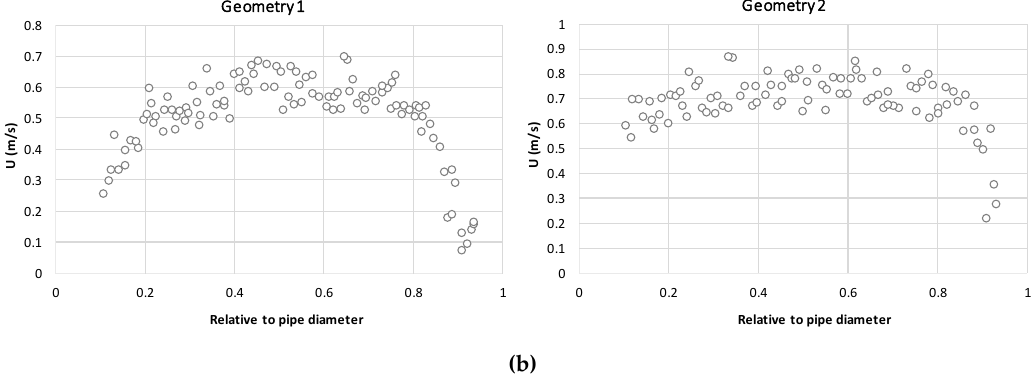
3 /h; ( b ) for 12 m 3